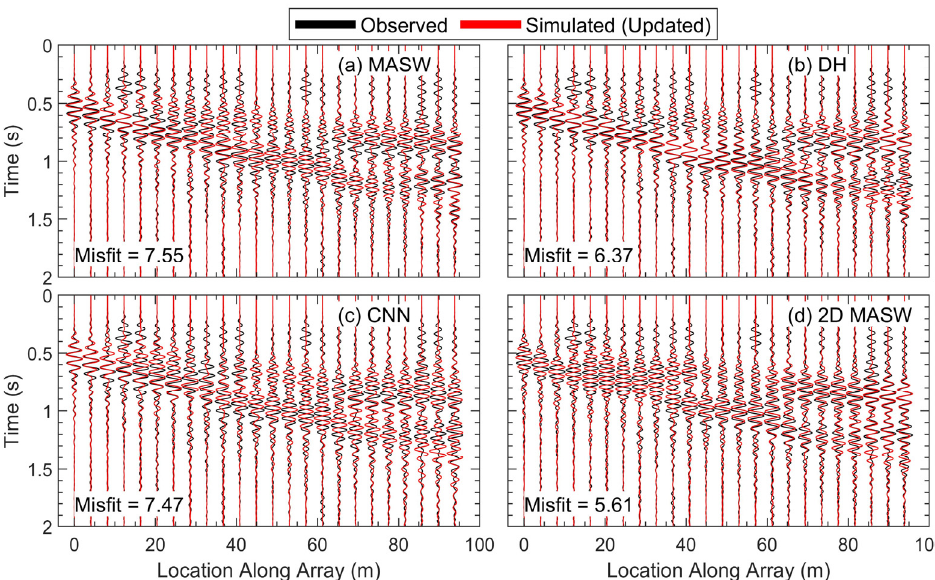
Figure 8. Normalized observed and simulated waveforms from Shot 1 ( − 24 m) for the updated models at the end of FWI Stage 1 (10 to 15 Hz) based on the: ( a ) MASW, ( b ) DH, ( c ) CNN, and ( d ) 2D MASW starting models. GSOTD misfit values for each set of simulated waveforms are shown in the bottom left of each plot. Note that for clarity purposes, the waveforms are only shown for every fourth channel used for FWI.